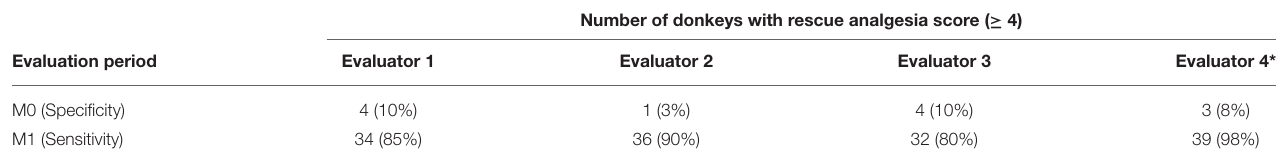
TABLE 9 | Number/percentage of donkeys with scores ≥ 4 (Youden index) indicative of rescue analgesia before and after surgery. Number of donkeys with rescue analgesia score ( ≥